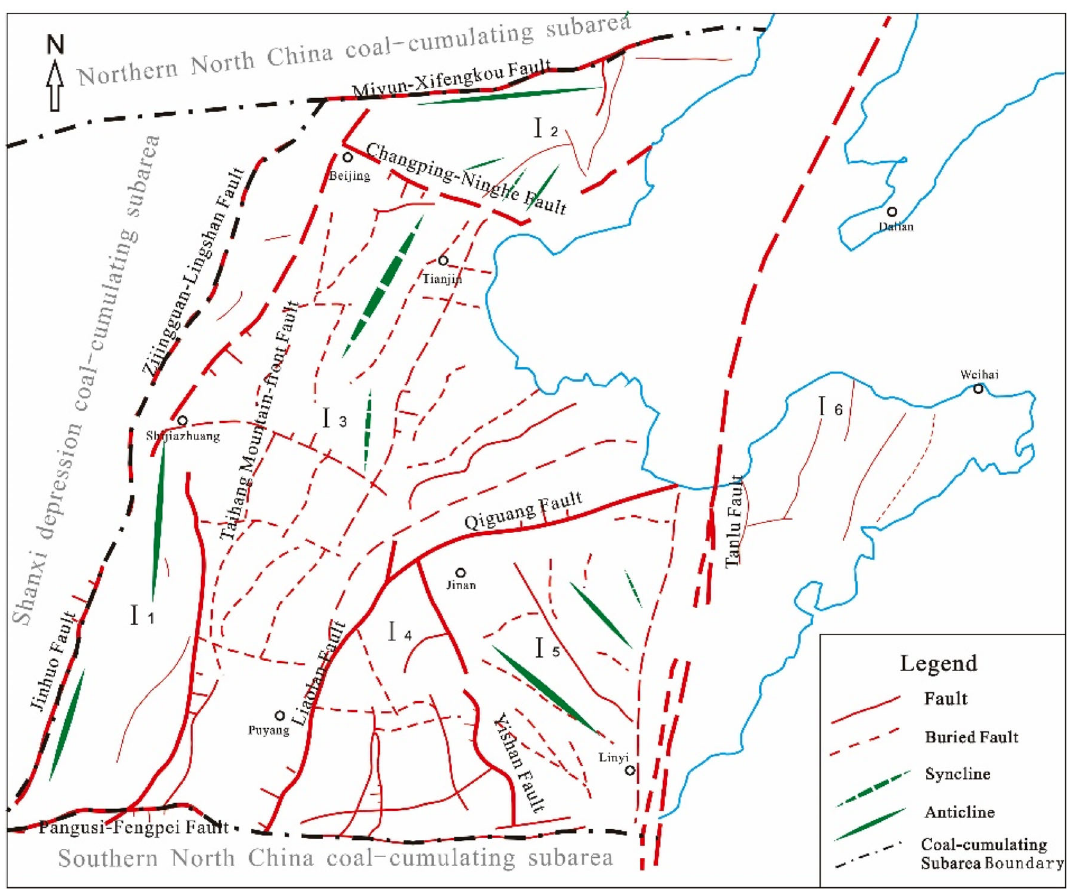
Fig. 7 Diagram of the coalfield structures in the Eastern North China coal occurrence structural subarea. I 1 –Eastern foothills of the Taihangshan coal occurrence fault block belt; I 2 –Southern foothills of the Yanshan coal occurrence fold belt; I 3 –North China plain coal occurrence fault depression belt; I 4 –Western Shandong coal occurrence fault depression belt; I 5 –Central Shandong coal occurrence fault-uplift belt; I 6 –Northern Shandong coal occurrence fault depression